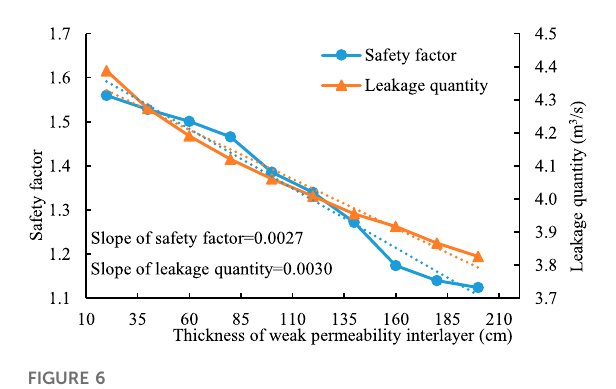
FIGURE 6 The curve between low-permeability interlayer thickness and leakage with the safety